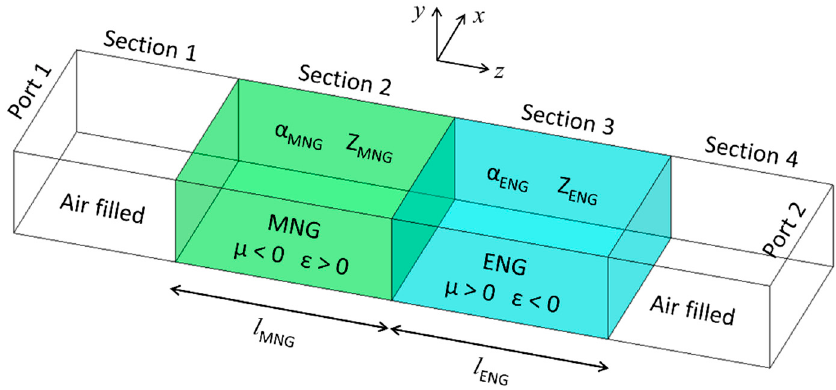
Figure 1. Schematic of a cascade of MNG and ENG metamaterial filled waveguide where tunneling (transmission from port 1 to port 2 or vice versa) is possible under certain conditions. (In color.).